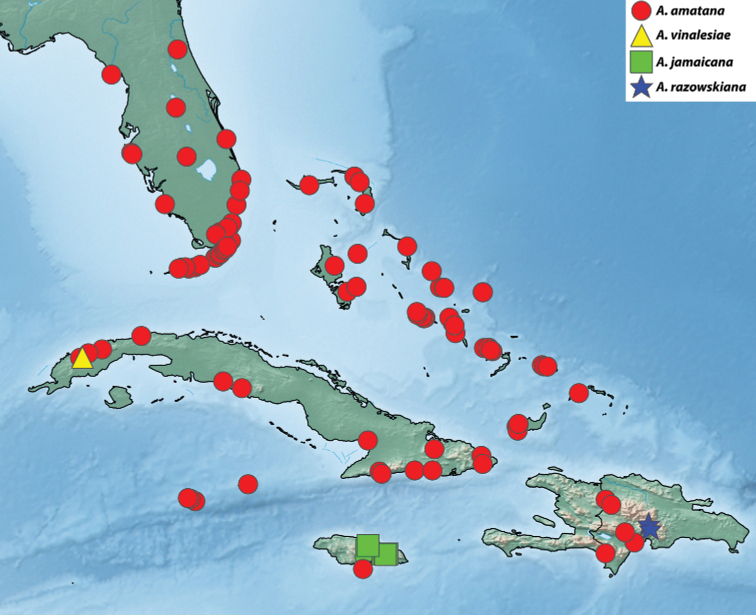
Argyrotaenia species distributions. Legend inset.